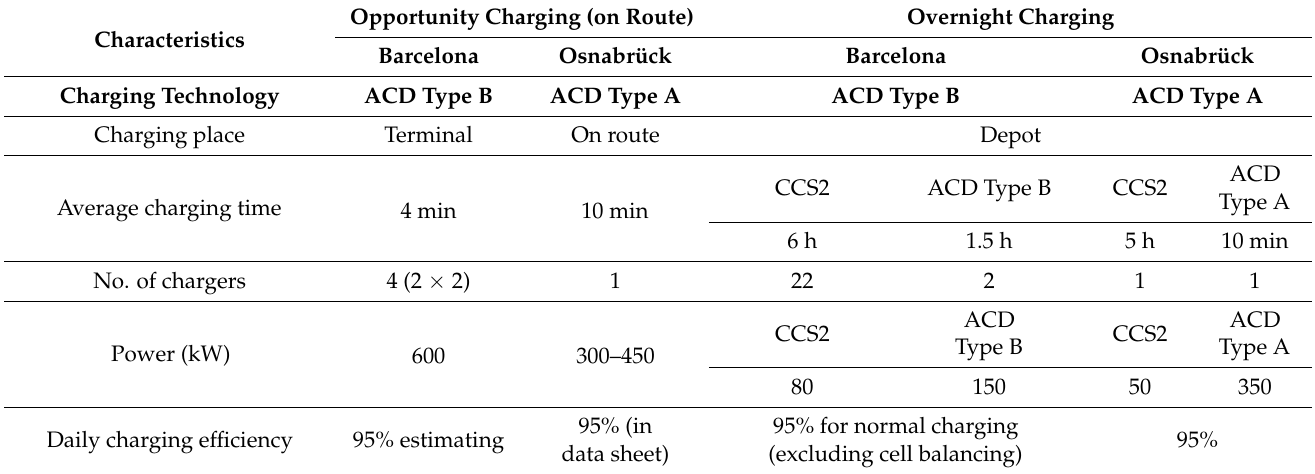
Table 3. Specifications of chargers in Barcelona and Osnabrück